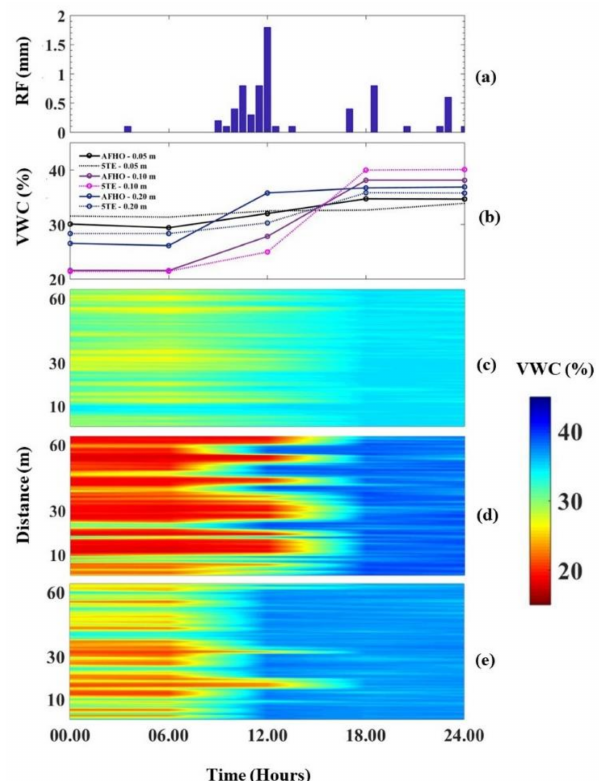
Figure 7. ( a ) Shows the pattern of rainfall during the period from 12 a.m. 13th August 2016 to 12 a.m. 14th August 2016 (24 h period); ( b ) shows the temporal changes in mean soil water content of transect 1 and soil water content measured by the 5TE sensors at three depths during the similar period, ( c – e ) shows the changes of soil water content of the transect 1 predicted by AHFO technique at 0.05, 0.10 and 0.20 m depths along the transect 1 (distance in meters), respectively.